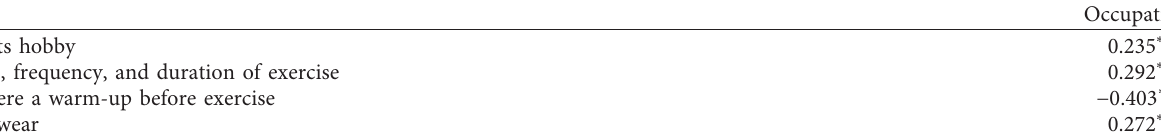
Table 14: Pearson correlation.